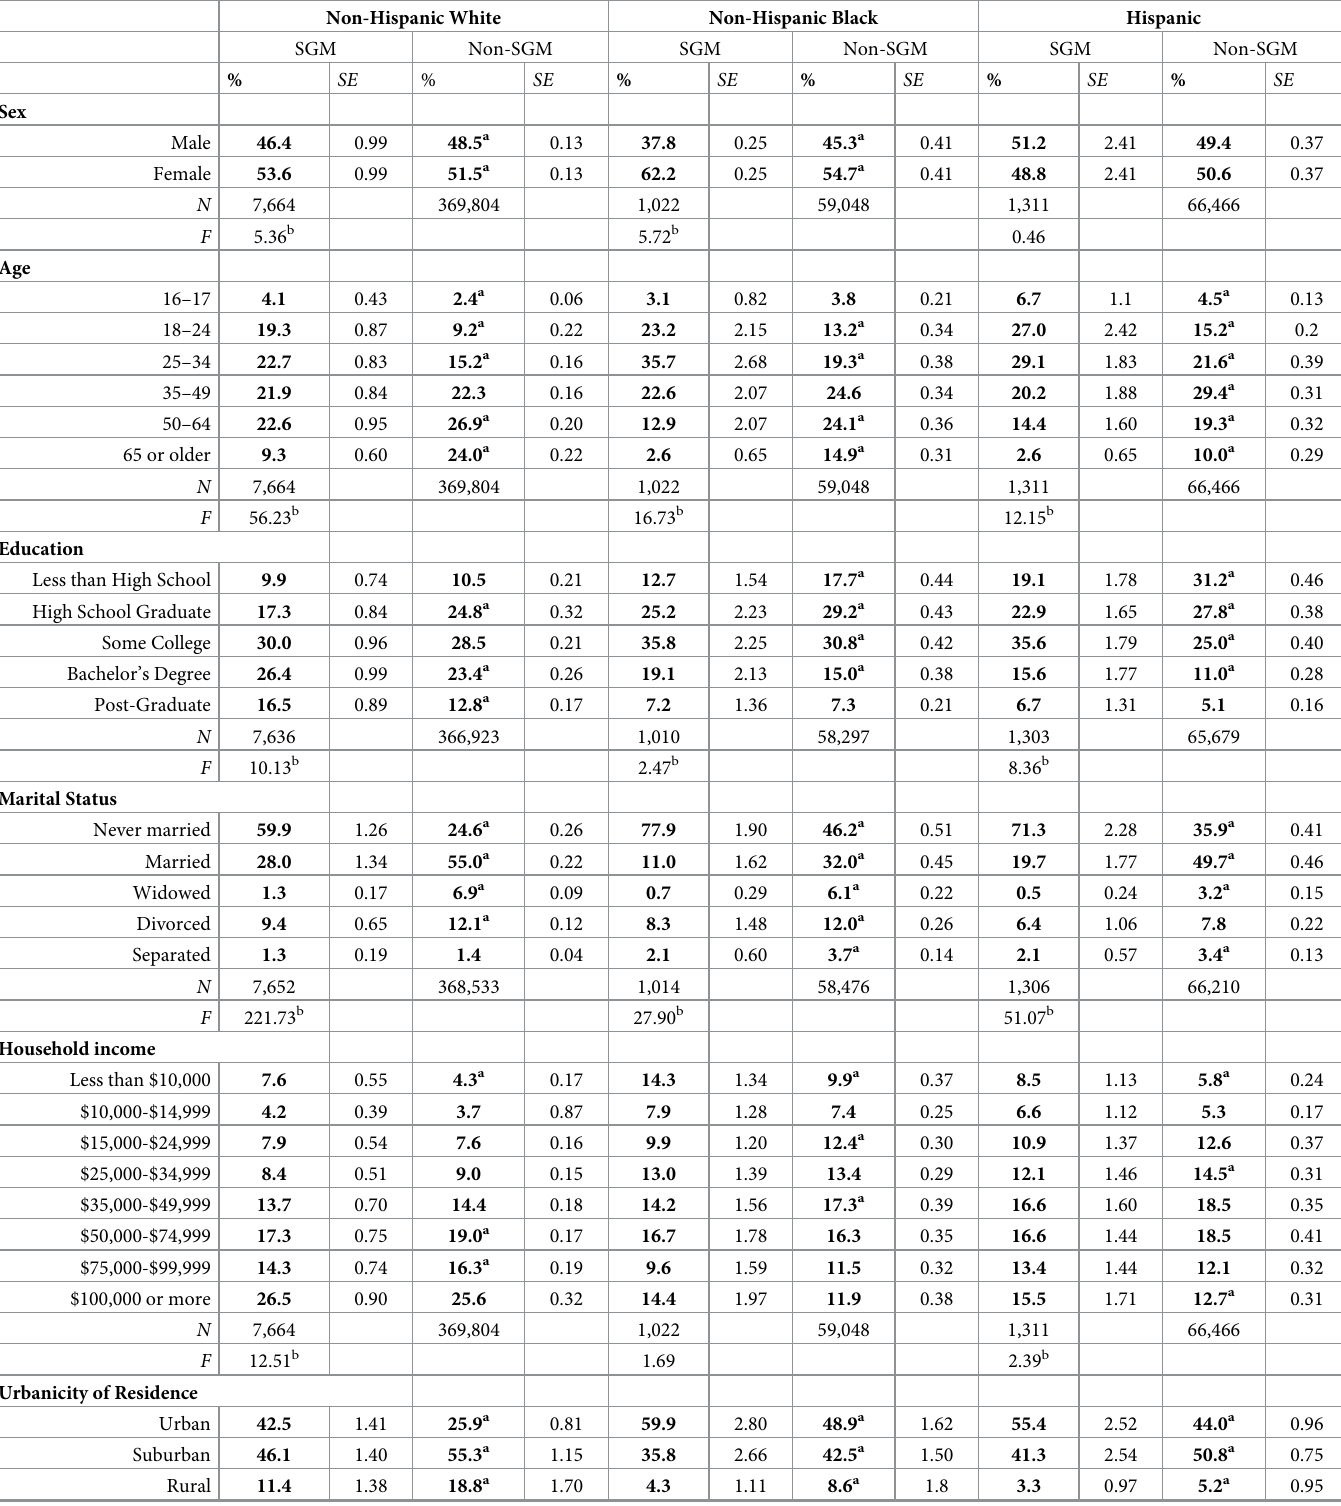
Table 1. Demographic characteristics SGMs and non-SMGs by race and